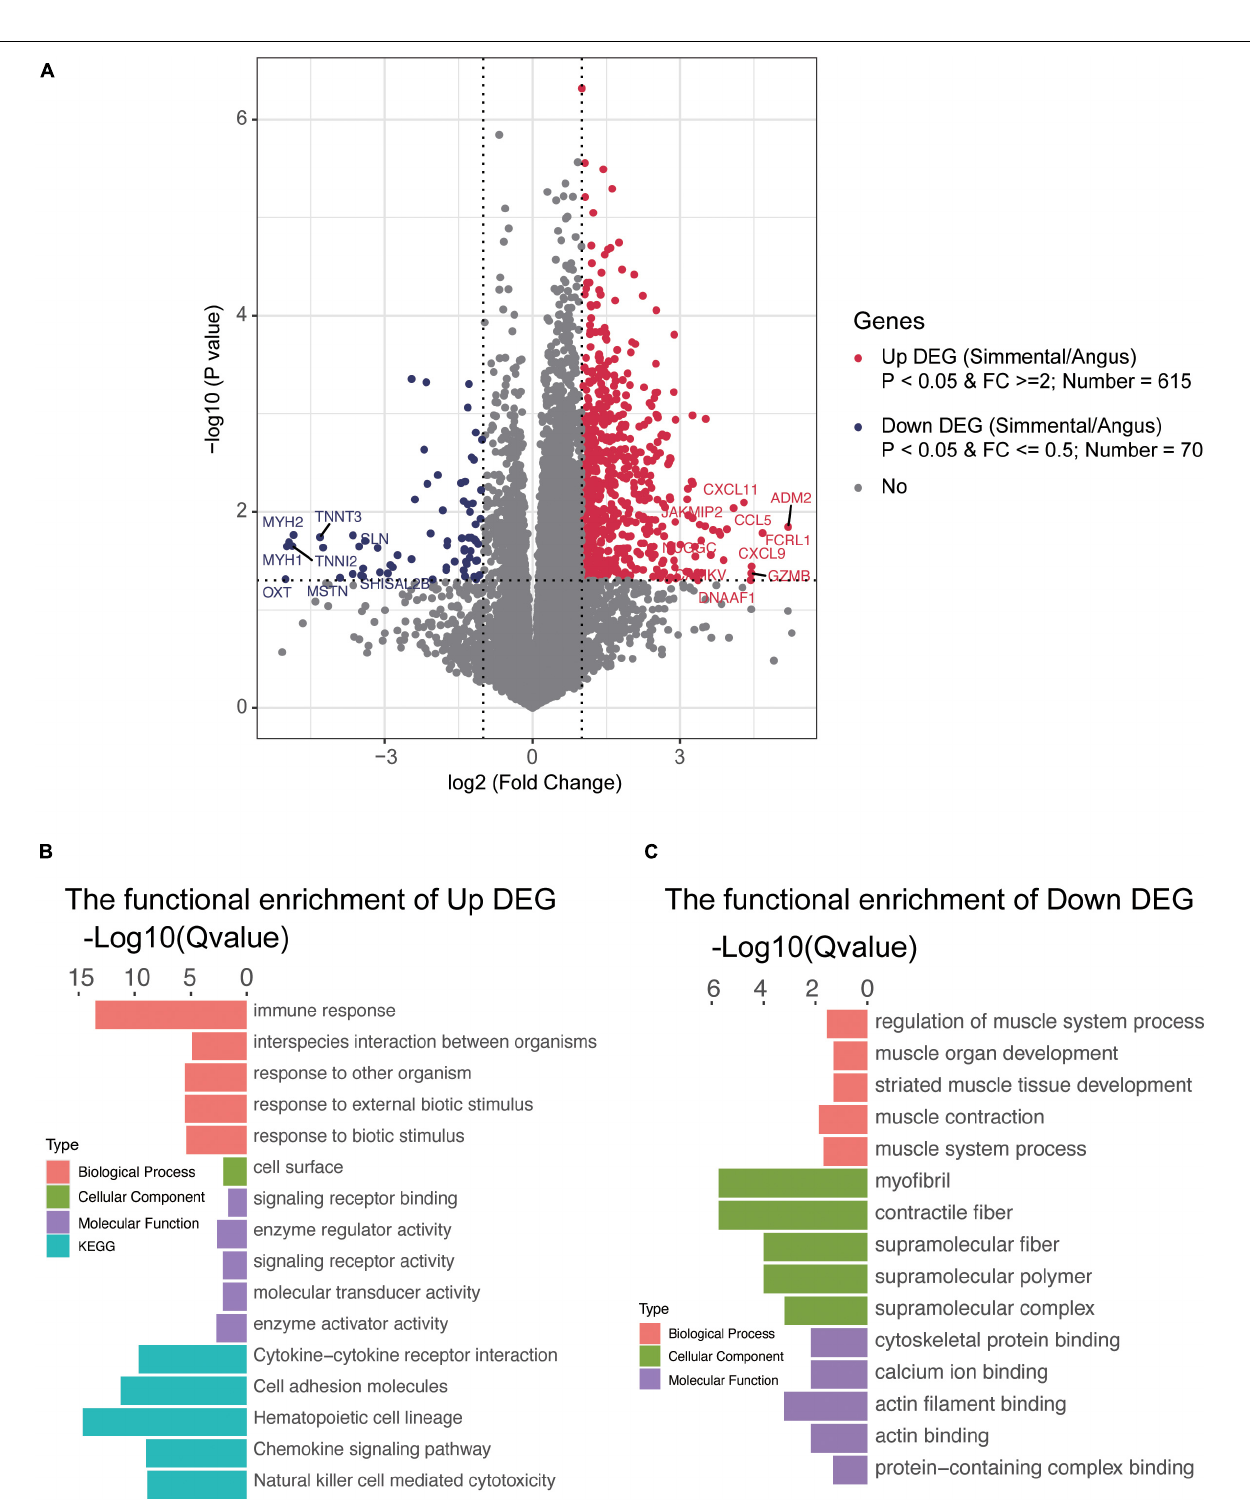
Frontiers in Microbiology |